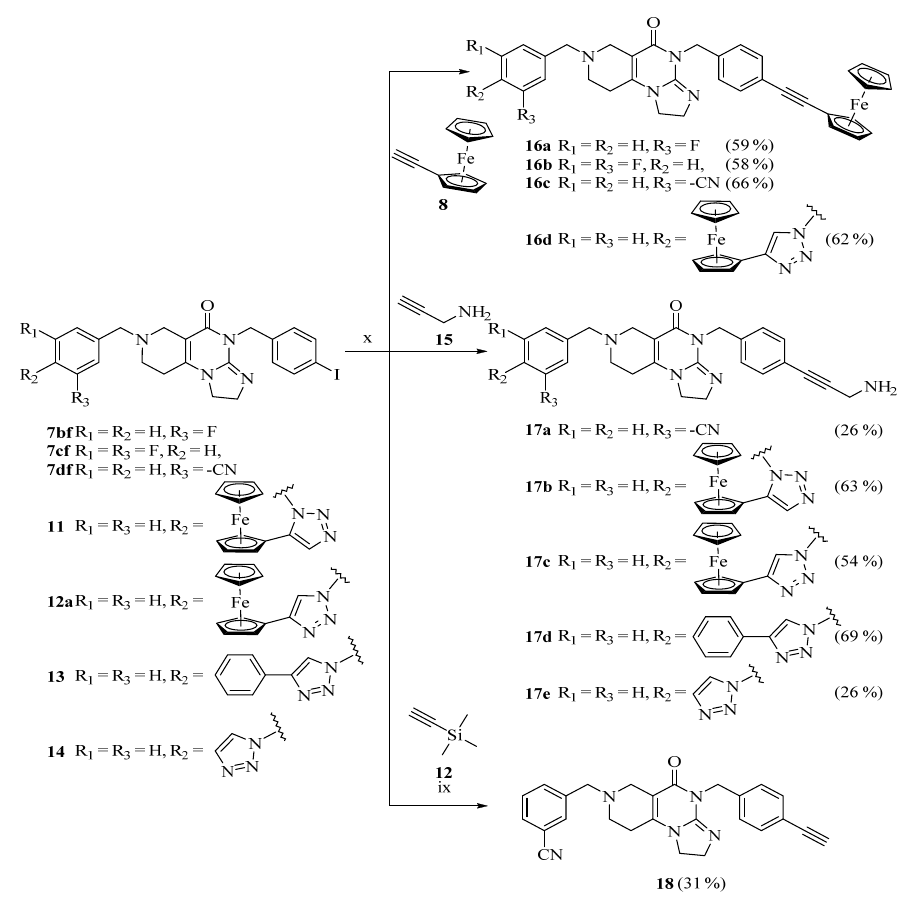
Scheme 3. Sonogashira couplings. Reaction conditions: (ix) TBAF (2 eq.), THF, r.t., 1.5 h; (x) 20% CuI,